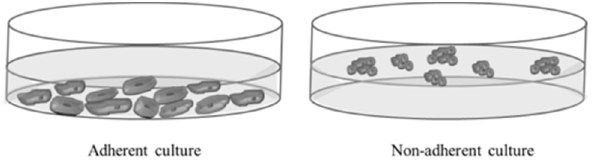
Figure 9. Schematic representation of adherent and non-adherent culture.